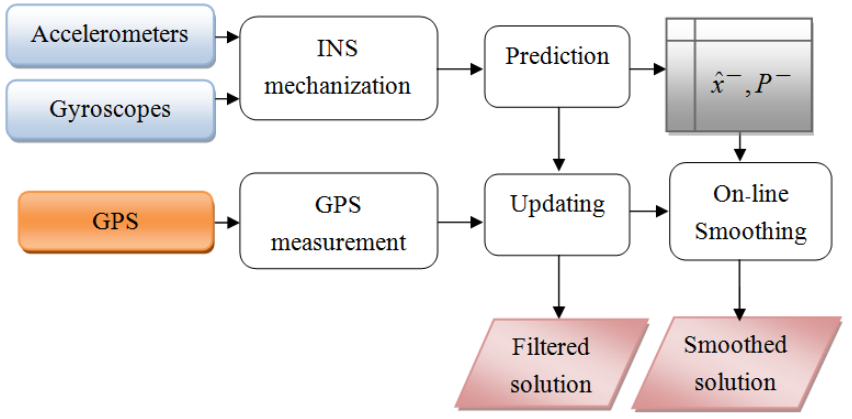
Figure 5. Integrated architecture with KF and on-line